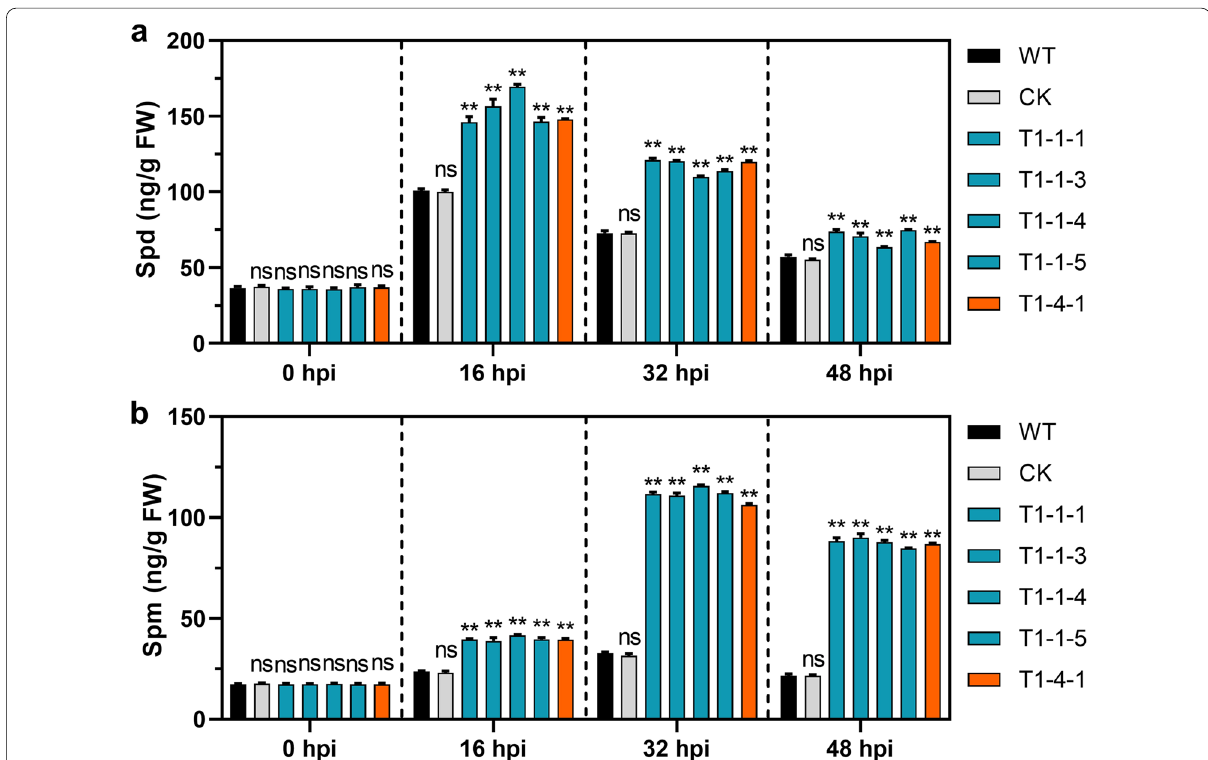
Fig. 3 Changes in the contents of Spd ( a ) and Spm ( b ) in transgenic soybean lines upon P. sojae inoculation. Error bar represents mean n represents sample number. All the experiments were performed three times (biological replicates) with similar results. The data were analyzed by Shapiro–Wilk test to determine the Normality and Lognormality Tests across groups, and then analyzed by one-way ANOVA with post-hoc Dunnett’s multiple comparisons test for groups that had passed the normality test (ns, no significant difference; ** P < 0.01). The exact n, SD values, and P values are shown in the